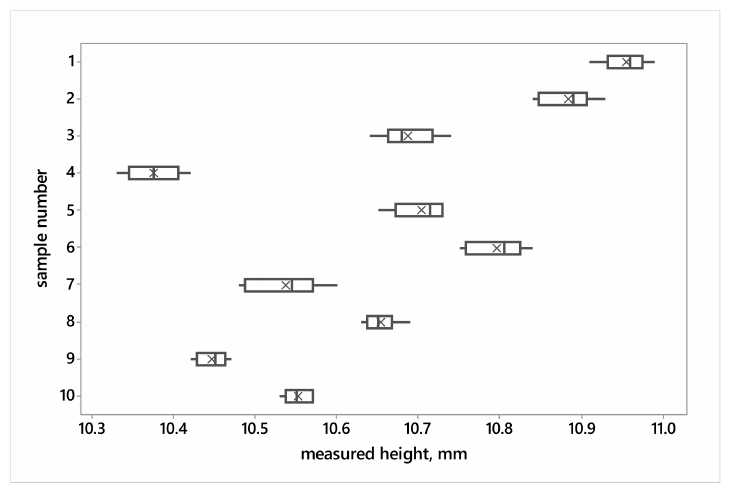
Figure 1. Box and whisker plots for unarranged product